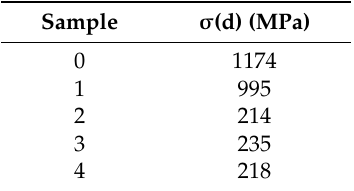
Table 8. Yield stress of the combustion chamber copper